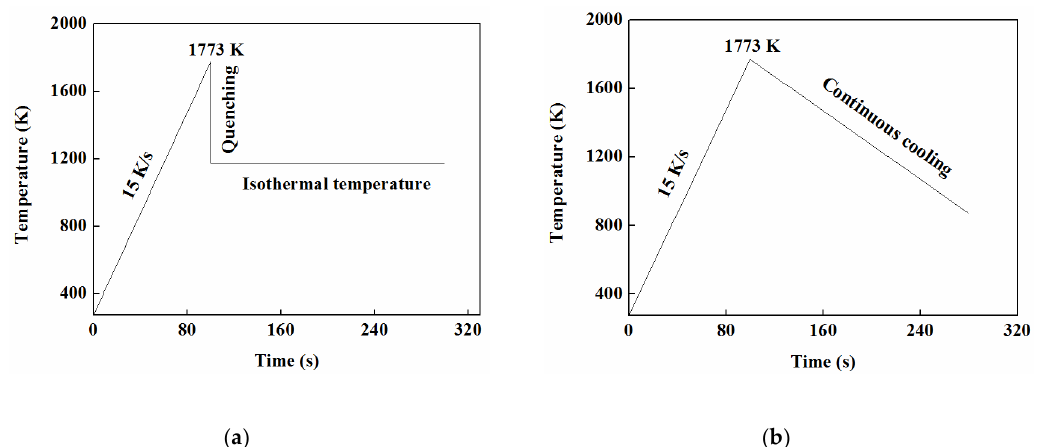
Figure 4. Thermal profile for ( a ) TTT and ( b ) CCT tests.